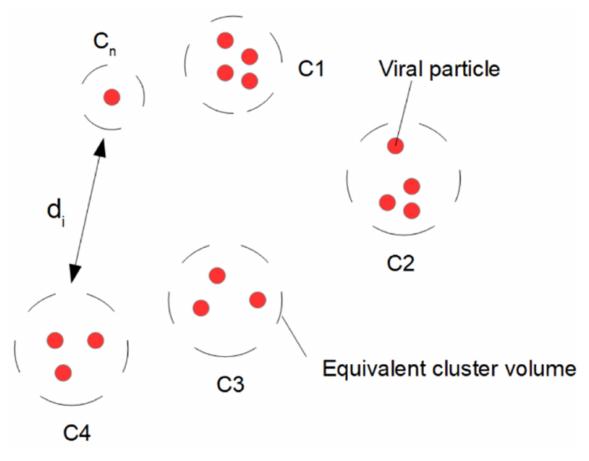
Figure 6. Cluster configuration.